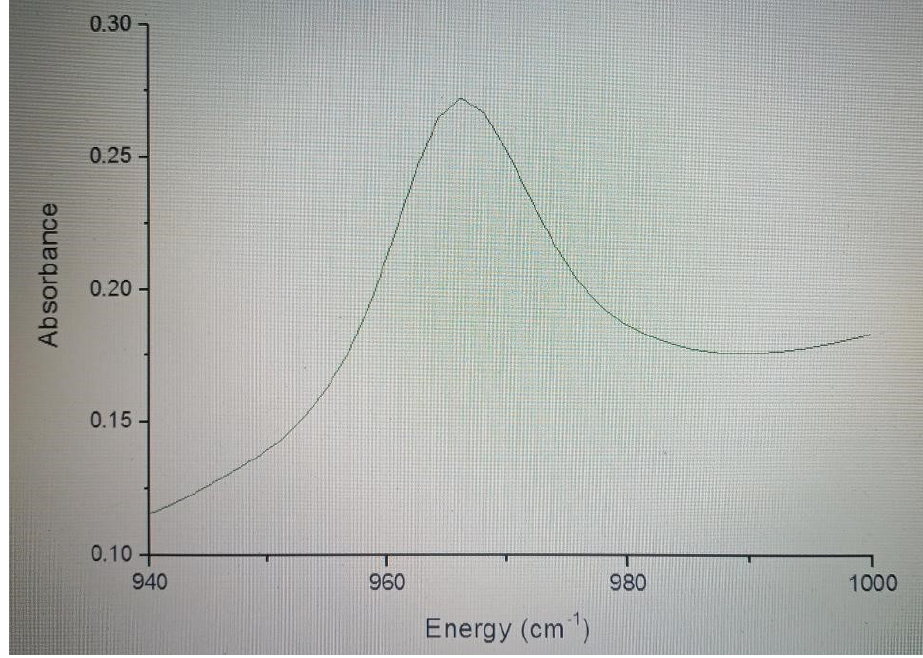
Figure 16. UV–Vis spectrum of TiO 2 scaffolds.